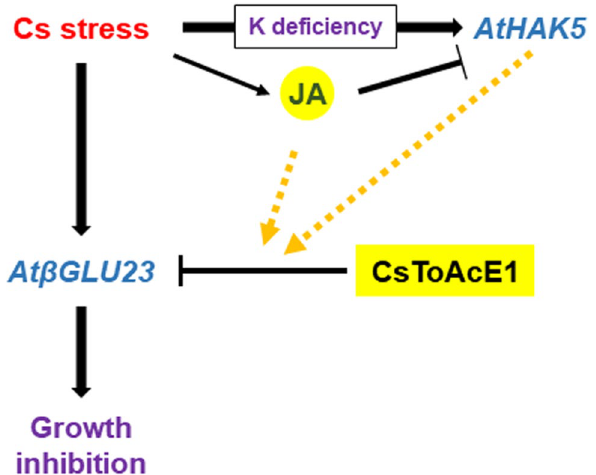
Figure 7. A proposed model for the binding of AtβGLU23 with CsToAcE1 under Cs stress conditions. Blue letters indicate the genes. Arrow bars indicate positive interaction and the orange arrow bars indicate possible positive interactions, respectively. T-signs bars indicate the negative interactions. JA indicates